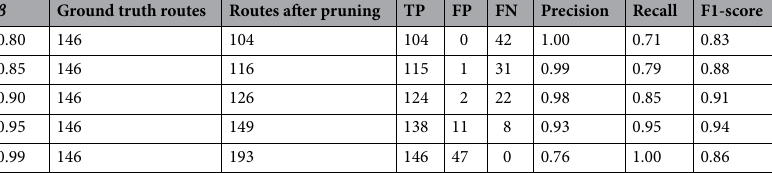
β Ground truth routes Routes after pruning